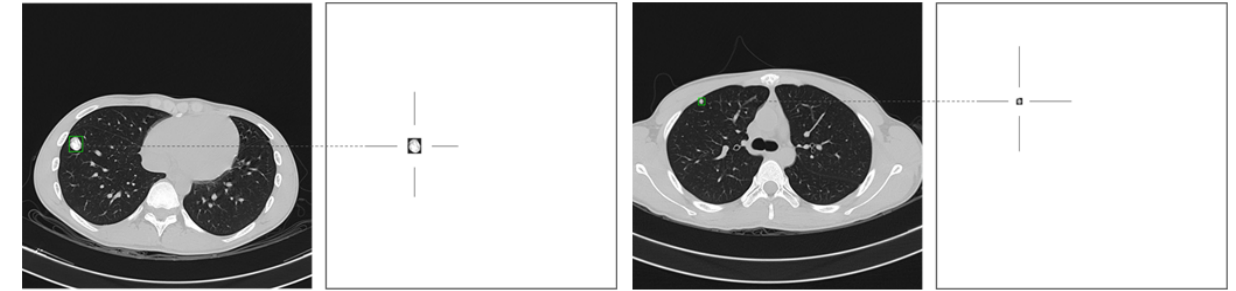
Figure 8. Example of nodule areas compared with image areas.